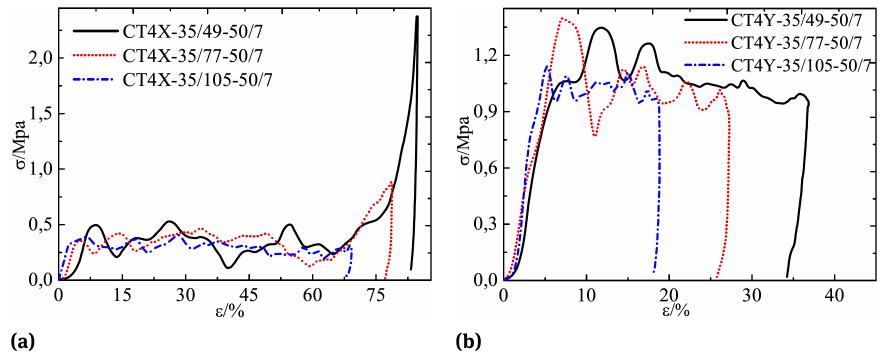
Figure 8: Dynamic compression curves for different tube lengths: (a) X- and (b) Y-direction paper corrugation tubes